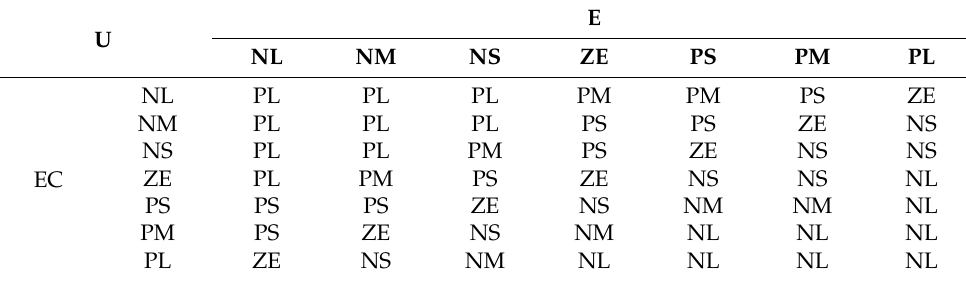
Figure 4. Membership function of input variable E, EC and output variable U. Table 2. Fuzzy rules of main fuzzy controller.